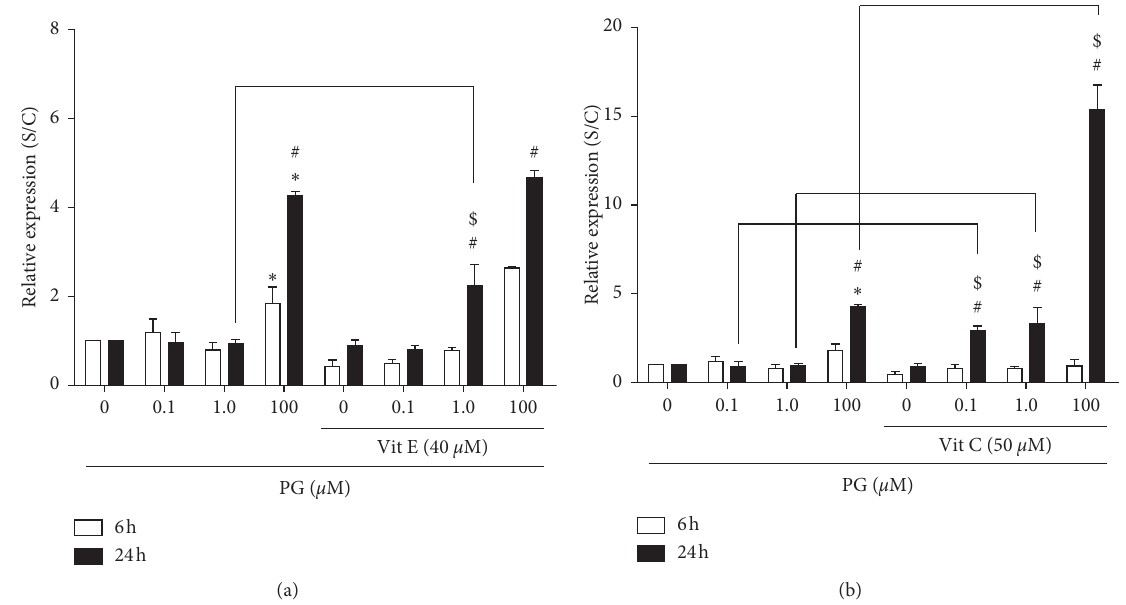
Figure 5: Expression of Hmox1 in progesterone-treated RINm5Fcells, in the presence of antioxidants. After preincubation with 40 μ M vitamin E (a) or 50 μ M vitamin C (b) for 2h, cells were incubated, for 6 or 24 h, with 0.1, 1.0, or 100 μ M progesterone. Data are presented as means ± SEM of three experiments in duplicates. ∗ indicates difference compared to control. # indicates difference between the incubation time points, for the same progesterone concentration. $ indicates difference in comparison to the treatment without antioxidants ( ρ < 0.05). PG: progesterone; Vit E: vitamin E; Vit C: vitamin